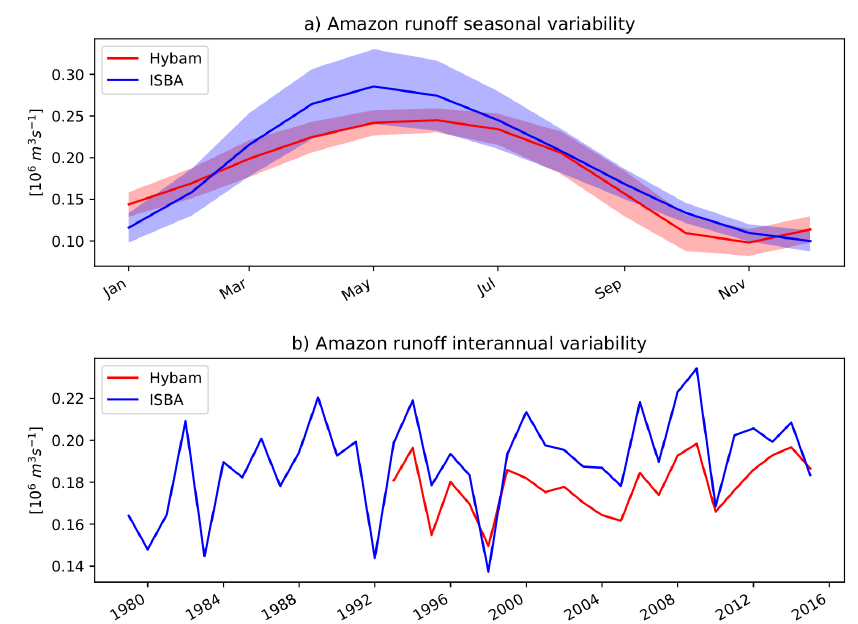
Figure 2. ( a ) Amazon runoff seasonal cycle and standard deviation (shaded) computed over the period 1993–2015. ( b ) Interannual variability from monthly time series. Data is from HyBAm measurements at Obidos station (red lines) and from ISBA-CTRIP model at the Amazon mouth (blue